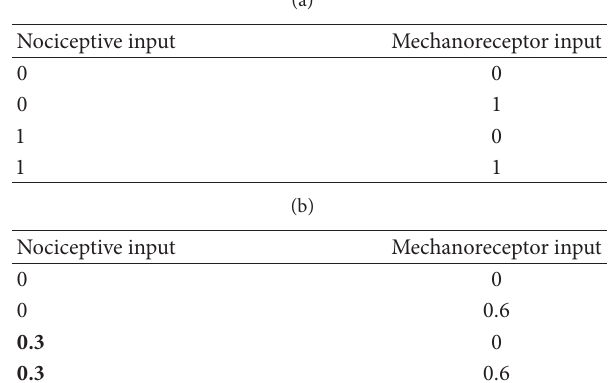
Table 1: Configuration of a standard training epoch: (a) shows four binary combinations in terms of the presence/absence of certain nociceptive/mechanoreceptor input. (b) represents the same table in terms of afferent nociceptors and mechanoreceptors’ firing probabilities. Taking into account that axons of afferent nociceptors are not myelinated, their firing probability is lower than in the case of afferent mechanoreceptors.